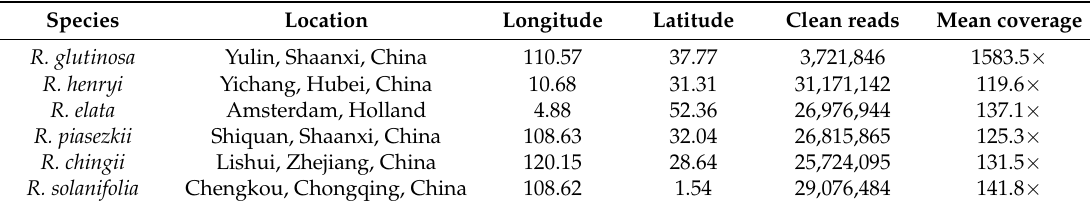
Table 1. Sample information of six Rehmannia species in this